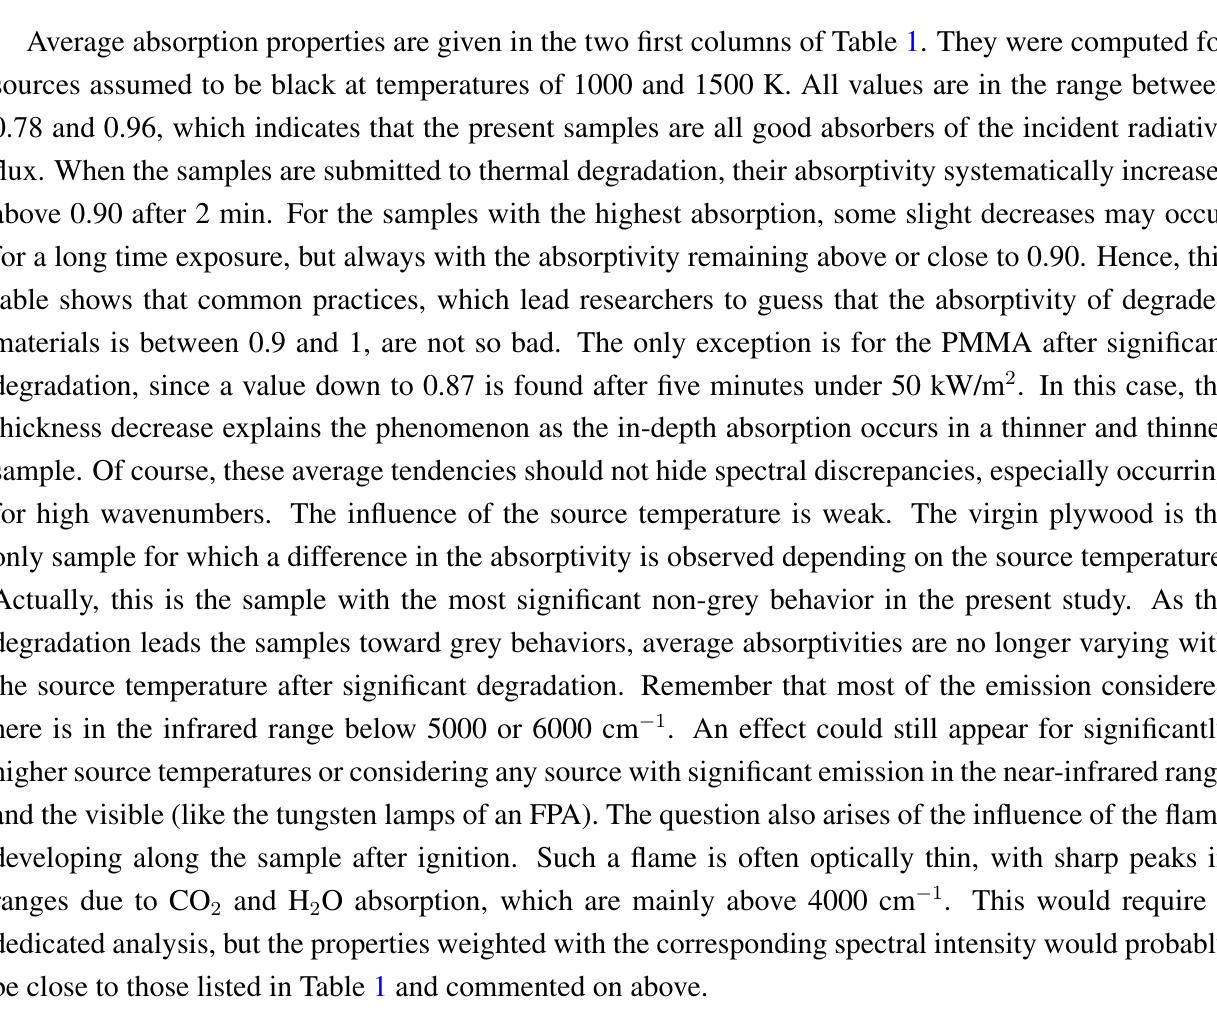
Figure 6. Reflectance, transmittance and absorptance evolution of a 15 mm-thick PMMA sample submitted to thermal degradation with an incident flux of 50 kW/m 2 during prescribed times. ( a ) Reflectance; ( b )